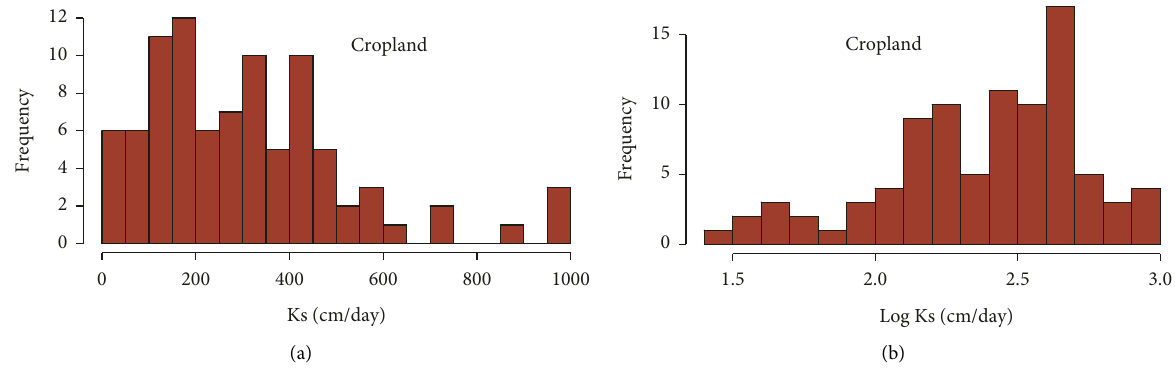
Figure 4: Histograms of K s (a) and Log K s (b) under cropland.